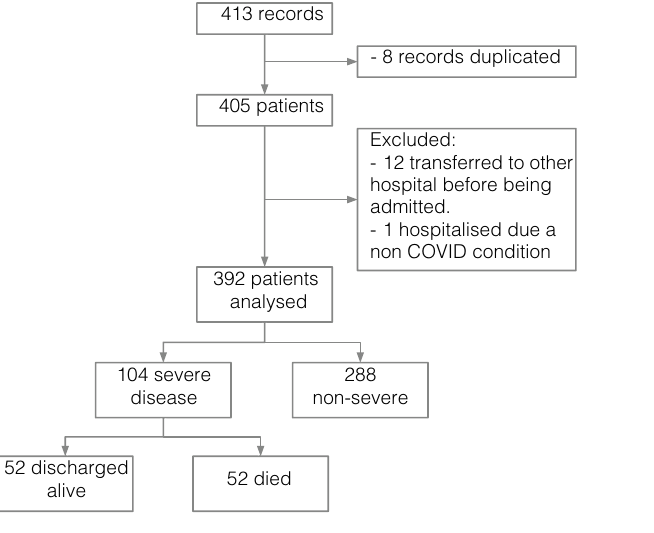
Figure 1. Participants